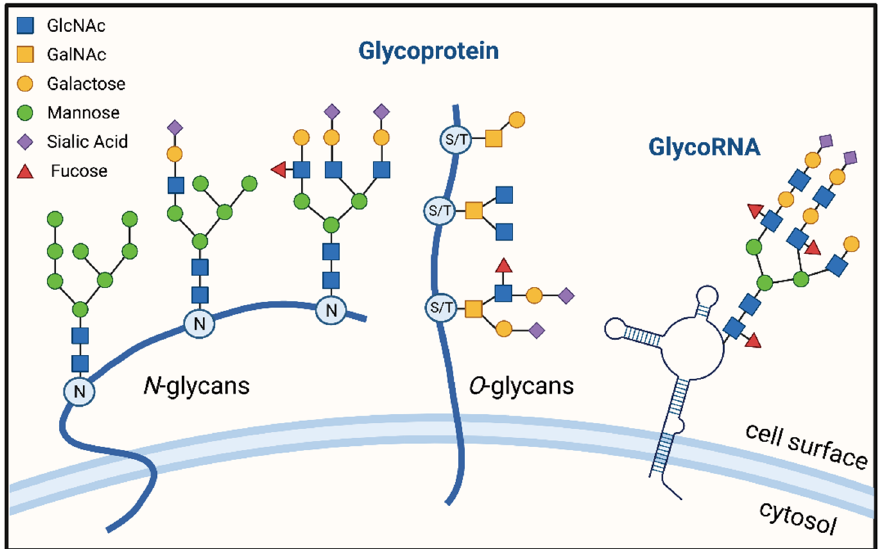
Figure 1. Model diagram of protein glycosylation (N-glycosylation and O-glycosylation) and RNA glycosylation. Created with BioRender.com on 14 October 2022.